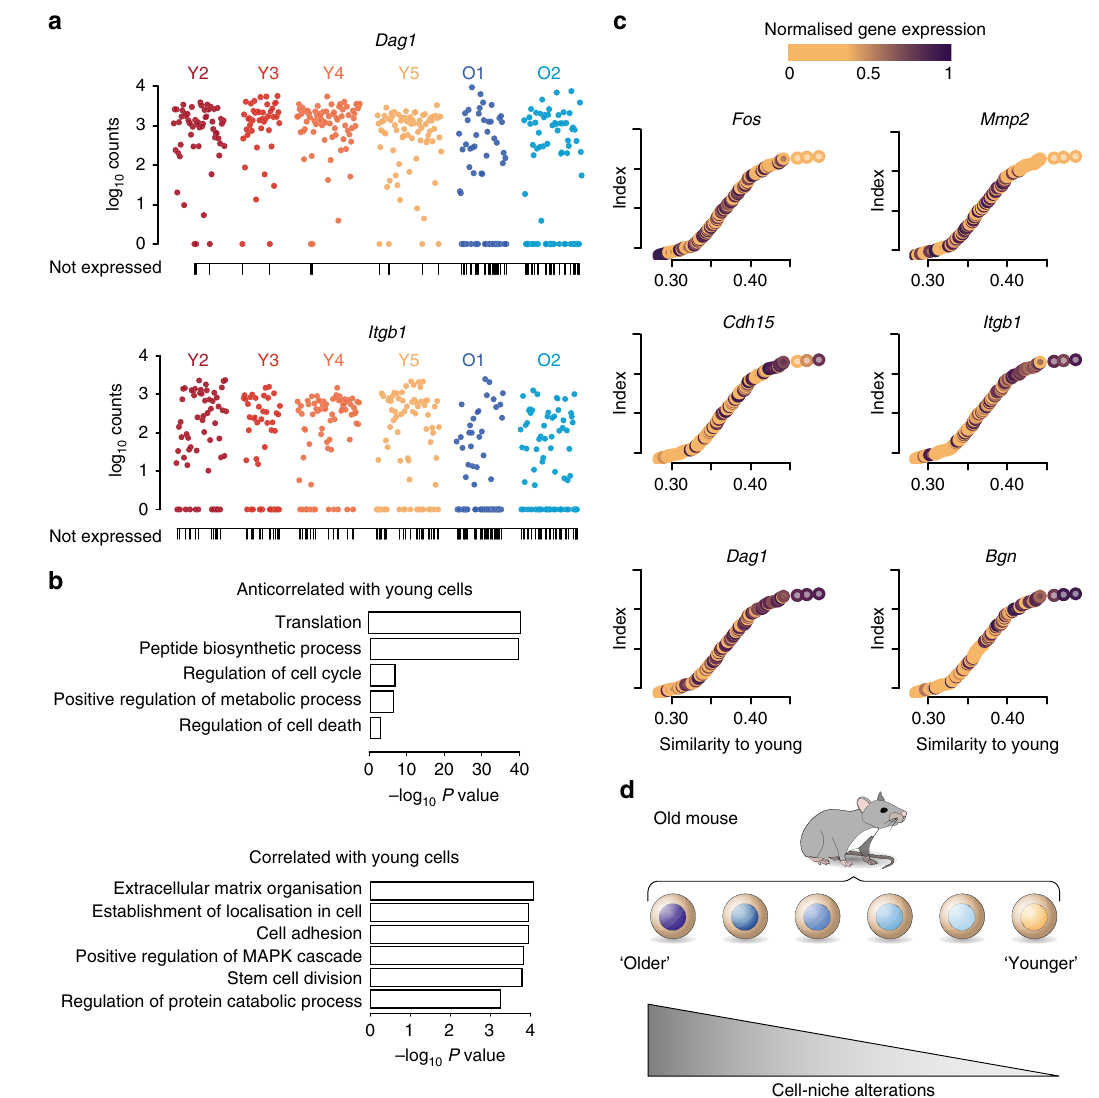
Fig. 2 Variability within aged muscle stem cells and cell-niche interactions. a Dag1 and Itgb1 expression in young and old cells. Each dot represents a cell. Vertical lines on the x -axis indicate cells that do not express the gene. Expression frequencies, Dag1 : young 0.96, old 0.65; Itgb1 : young 0.79, old 0.59. b P -values of the GO terms associated with the top 200 anticorrelated (top) and correlated (bottom) genes with the similarity score to young cells. c Similarity between old and young cells. Each dot represents an old cell; on the x -axis old cells are ordered according to their similarity (Spearman correlation coef fi cient) to young cells (young mean expression). Colours indicate the normalised levels of expression of selected genes correlated across ordered cells. Source data are provided in Supplementary Data 3. d Model: aged muscle stem cells that have the most different transcriptomes from young stem cells are likely to have impaired stem cell-niche interactions and are more prone to exit